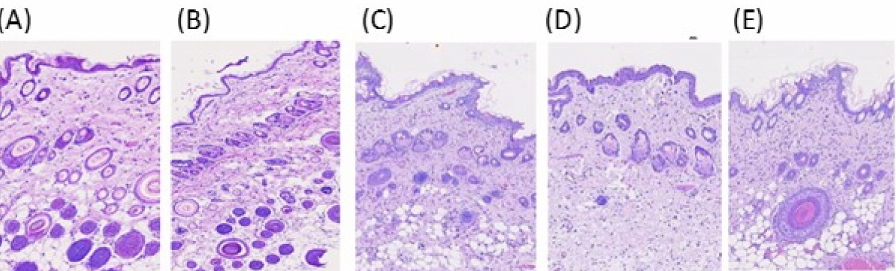
Figure 3. The photomicrographs of rat skin section with different treatments viewed under a light microscope (4 × 10): ( A ) the intact skin showing integrity; ( B ) the paraformaldehyde-treated skin showing slight edematous exfoliation of the stratum corneum (SC) and loosely textured collagen in the dermis; ( C ) blank M3-treated skin showing well-defined epidermal and dermal layers; ( D ) M3 containing 5% drugtreated; ( E ) commercial formulation-treated, showed slight edematous exfoliation of the